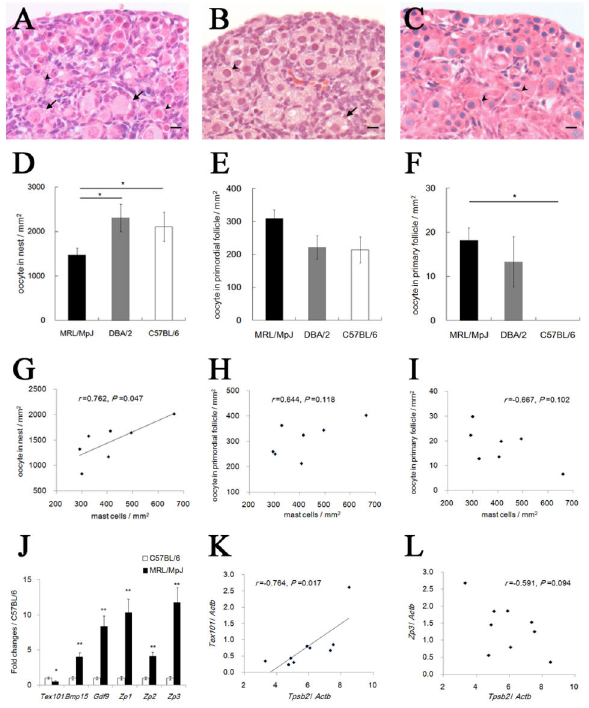
Figure 6. Early follicular development in the ovary of neonatal mice. (A–C) Mouse ovaries at postnatal day 0. Sections from MRL/MpJ (panel A), DBA/2 (panel B), and C57BL/6 (panel C) mice were stained using hematoxylin and eosin. In all strains, the oocytes just beneath the surface epithelium are found in large clusters called nests, whereas some oocytes are enclosed in primordial follicles in the deep cortex (panels A-C, arrowheads). In addition, MRL/MpJ (panel A) and DBA/2 (panel B) mice contain a few primary follicles in the deep cortex (arrows). Bars: 10 µm. (D–F) The number of oocytes in the mouse ovaries at postnatal day 0. DDX4-positive oocytes per ovary area were counted according to 3 developmental stages: nest (panel D), primordial follicle (panel E), and primary follicle (panel F). Data represent the mean ± SEM (n = 4–7 in each group). (G–I) Correlation between the number of mast cells and oocytes in the nest (panel G), primordial follicle (panel H), and primary follicle (panel I) in MRL mice at postnatal day 0 (Pearson’s correlation test, n = 7). (J) qPCR analyses of Tex101 , Bmp15 , Gdf9 , Zp1 , Zp2 , and Zp3 genes at postnatal day 0. Data represent the mean ± SEM (n = 7–9 in each group). (K and L) Correlation between the gene expression of Tpsb2 and Tex101 (panel K) or Zp3 (panel L) in MRL mice at postnatal day 0 (Pearson’s correlation test,